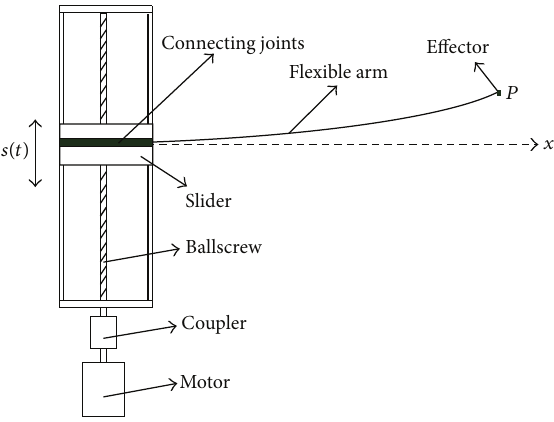
Figure 1: Schematic diagram of the motor driven